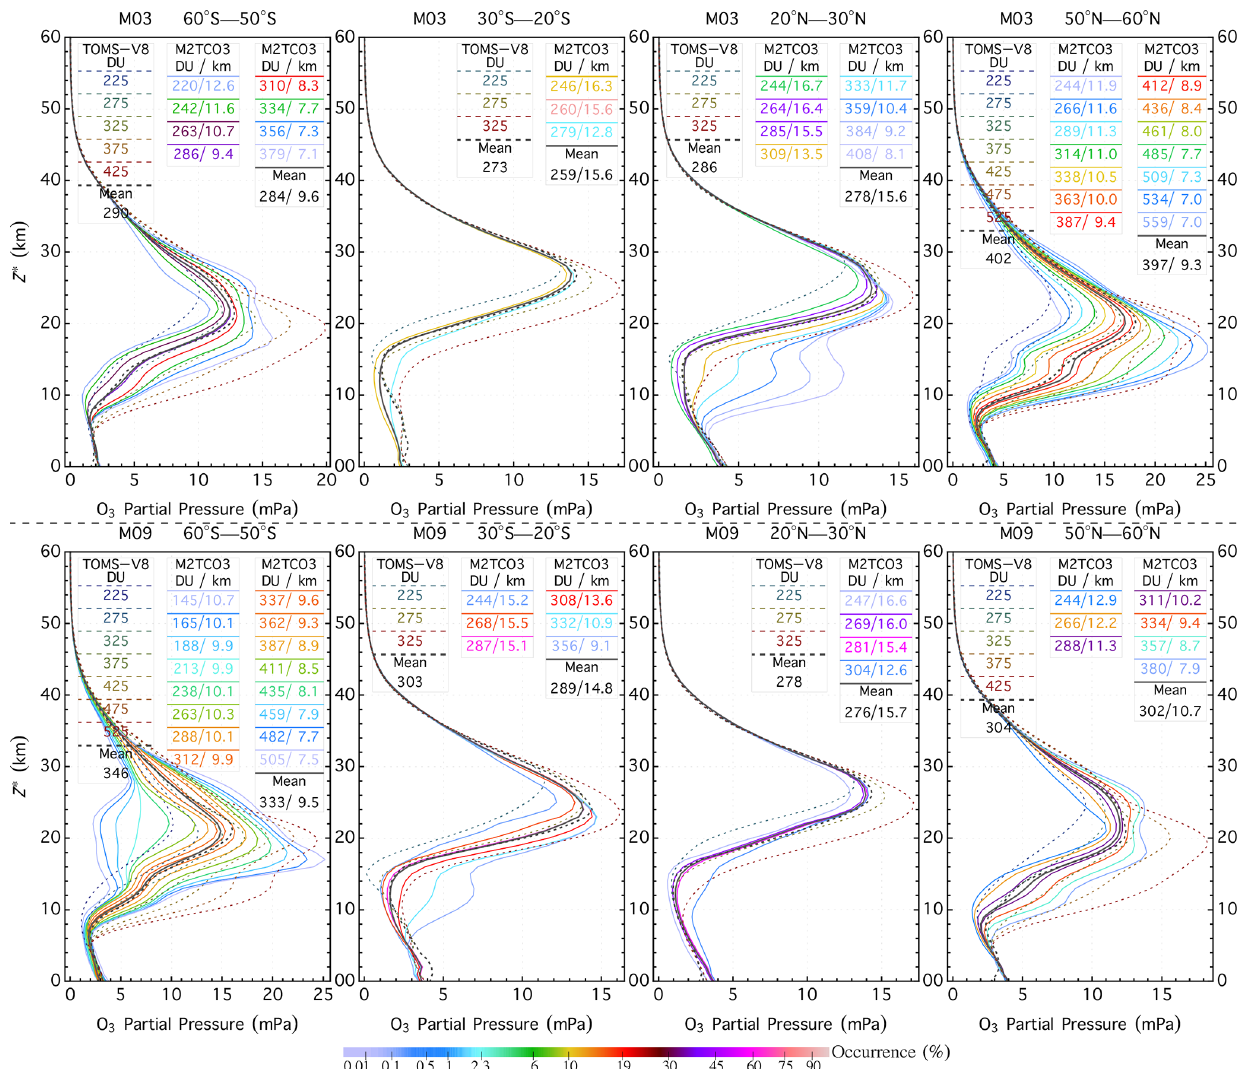
Figure 11. Profile comparisons between M2TCO3 and TOMS-V8 for 2 months (March and September) and four latitude zones: 60–50 ◦ S, 30–20 ◦ S, 20–30 ◦ N, and 50–60 ◦ N. Colored solid lines represent M2TCO3 profiles, while the dotted ones are for TOMS-V8 profiles. The color of a solid line indicates the percentage occurrence of the climatological profile, and its line legend displays the mean tropopause altitude and the mean total column O 3 of the profile. The solid black lines represent the downgraded M2TCO3 (i.e., the monthly zonal mean) profiles, and dotted lines are TOMS-V8 monthly zonal mean (i.e., the LLM climatological) profiles. Here pressure altitude is defined as (cid:104) p (cid:105) s Z ∗ = 16log 10 , where p is pressure level (in hPa) and p s = 1013 . p